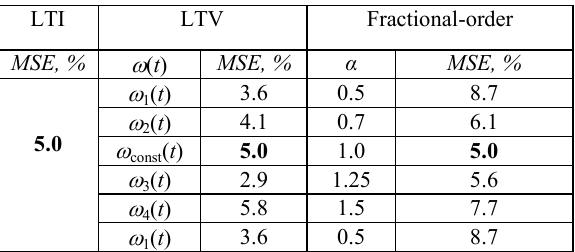
Table 1. Mean square error of the filters response for the a few considered examples of low-pass